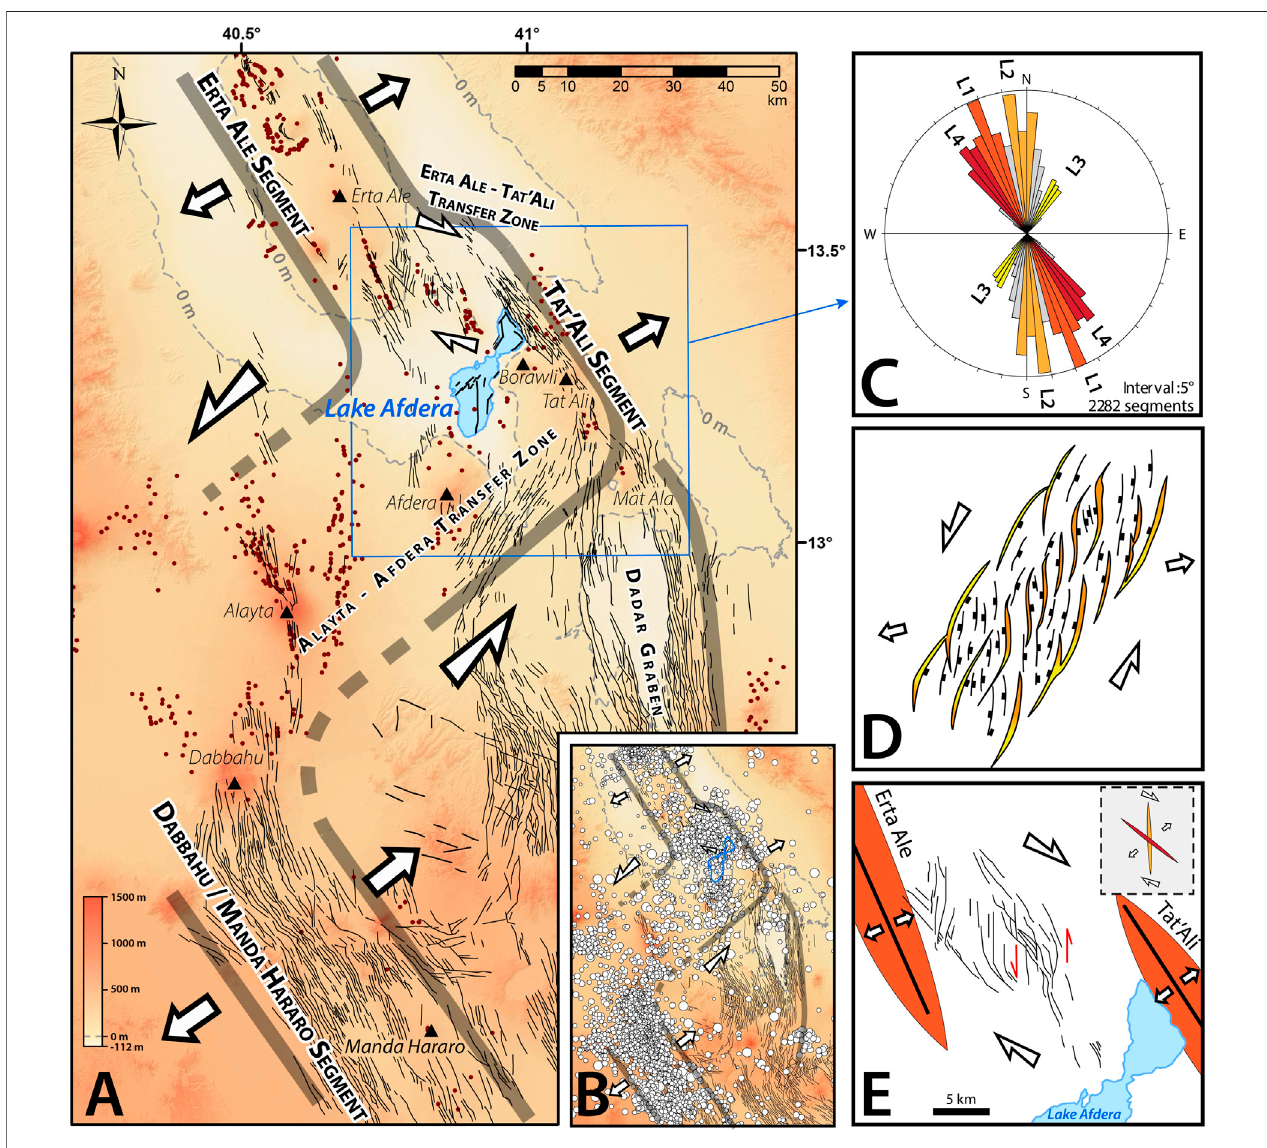
FIGURE 5 | Structural analysis of the larger Afdera region. (A) : Mapping of tectonic lineaments (in black) and of volcanic cones or vents (in brown). (B) : Earthquake compilationinthestudyareabyZwaanetal.(2020)includingdatafromKeiretal.(2006),Belachewetal.(2011)andIllsely-Kempetal.(2018). (C) :Length-weightedrose diagram showing the orientation of the tectonic lineaments around lake Afdera in the area represented by the blue square on (A) . (D) : Results of analogue modeling of oblique rifting by McClay et al. (2002). The colors represent the orientations shown on panel (B) . Comparison between the Alayta – Afdera Transfer Zone and the modelofMcClayetal.(2002)showsstrikingsimilaritiesinfaultorientation.ThistranstentionalsystemishenceinterpretedtohaveformedtheL2andL3faultorientations. (E) :StructuralinterpretationoftheErtaAle – Tat ’ AliTransferZoneredrawnafterLaRosaetal.(2019,2021).ItshowsthatthistransferzoneformedL2andL4orientations.